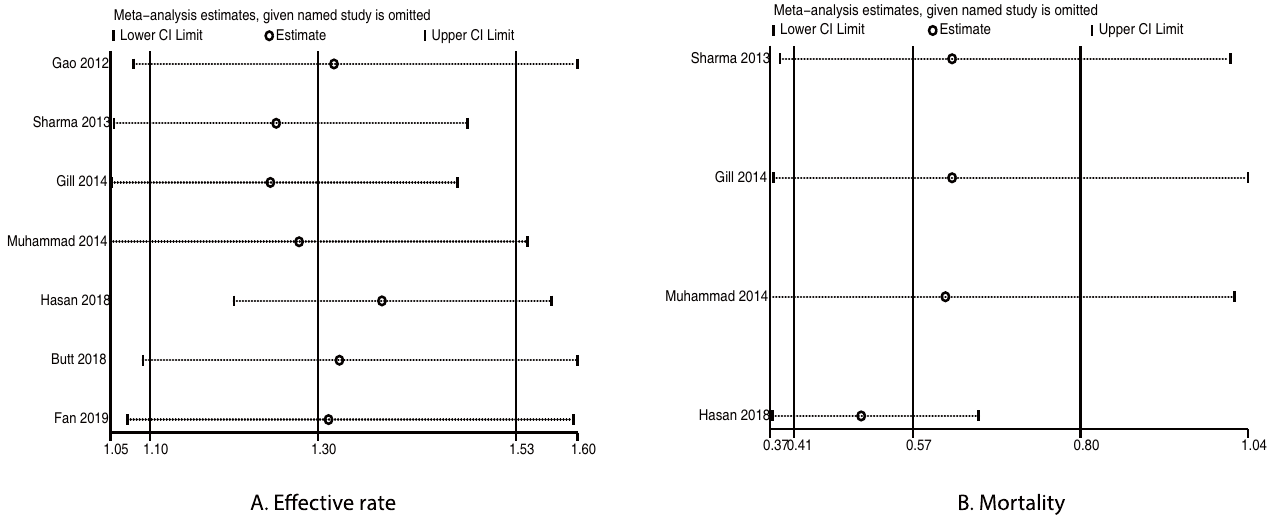
Meta−analysis estimates, given named study is omitted